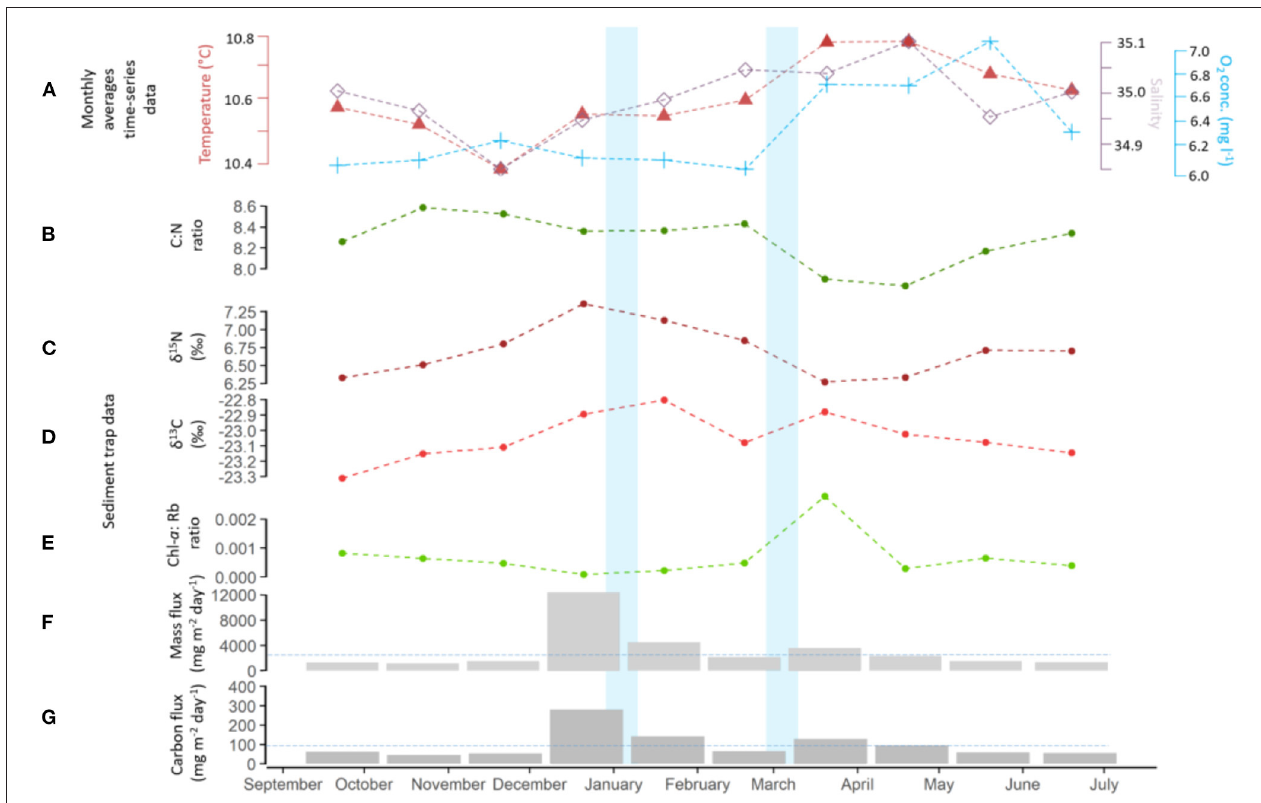
FIGURE 6 | (A) Monthly averages of temperature, salinity and oxygen concentration recorded by the lander, Sediment trap data: (B) C:N ratio; (C) δ 15 N; (D) δ 13 C; (E) Chlorophyll-a: Phaeopigments ratio of the sediment trap material; (F) Mass and (G) Carbon flux recorded by the sediment trap. Blue horizontal lines are indicating the average mass and carbon flux. Line charts and histograms represent the average value during the 30 day sediment trap interval. Storm events are highlighted in light